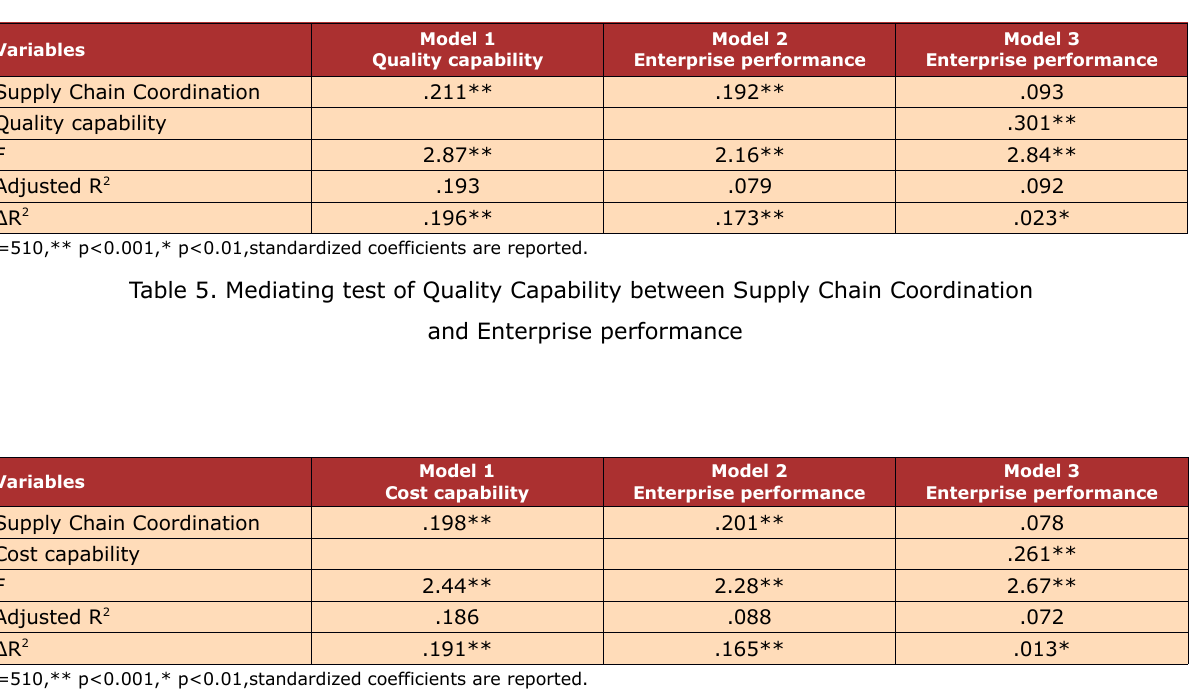
Table 6. Mediating test of cost capability between Supply Chain Coordination and Enterprise performance